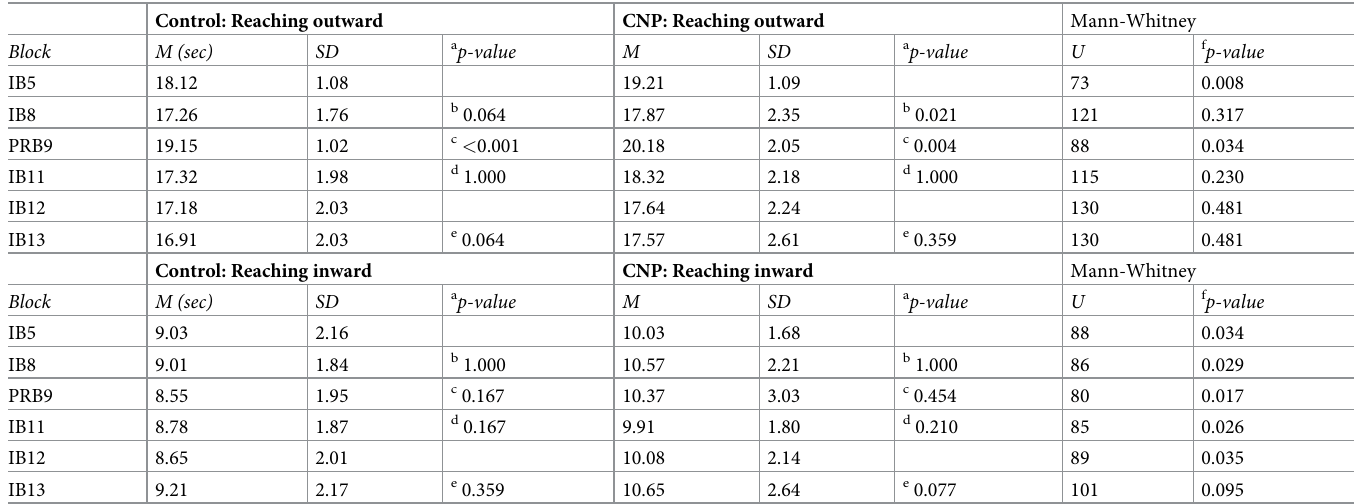
Table 6. Implicit motor learning within group and between group differences. Control: Reaching